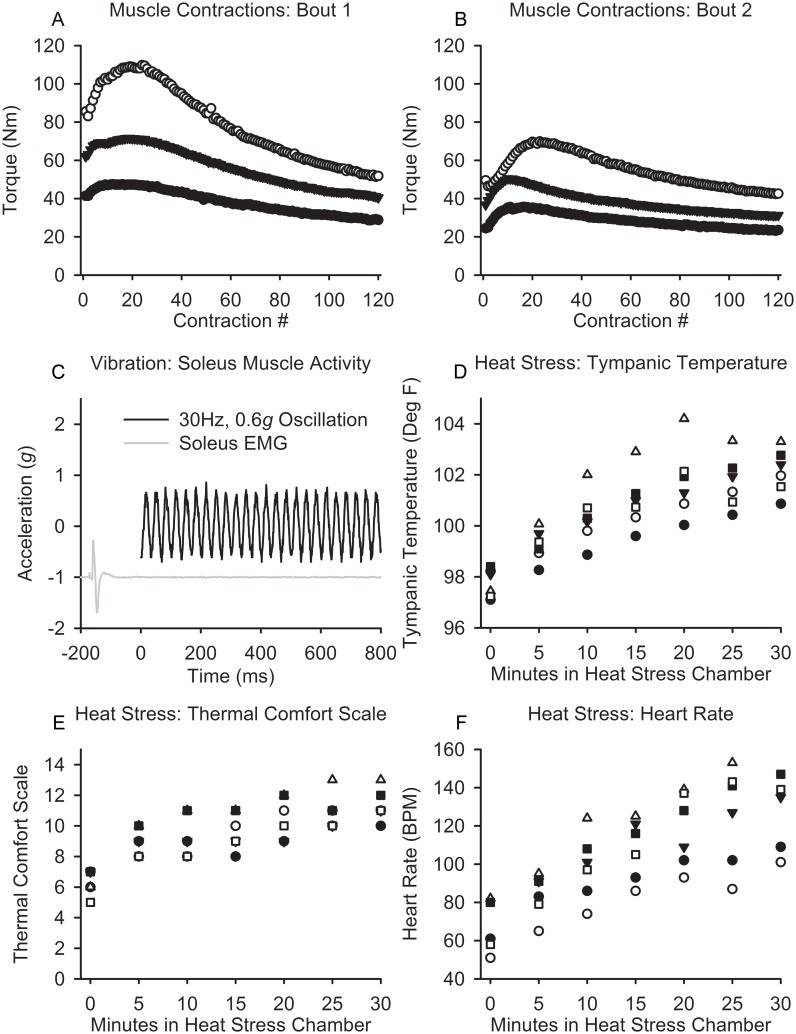
Physiological Effects after Muscle Contraction, Vibration, and Heat.(A and B) The torque curve from the soleus muscle during bout 1 and bout 2 during the muscle contraction stressor with decreased torque production by the end and between the bout 1 and bout 2. Representative example of the level of EMG muscle activity compared to the maximum M-wave during the bout of unilateral muscle vibration. (D, E, F) The temperature, self-reported comfort, and heart rate during the passive, whole-body heat stressor.